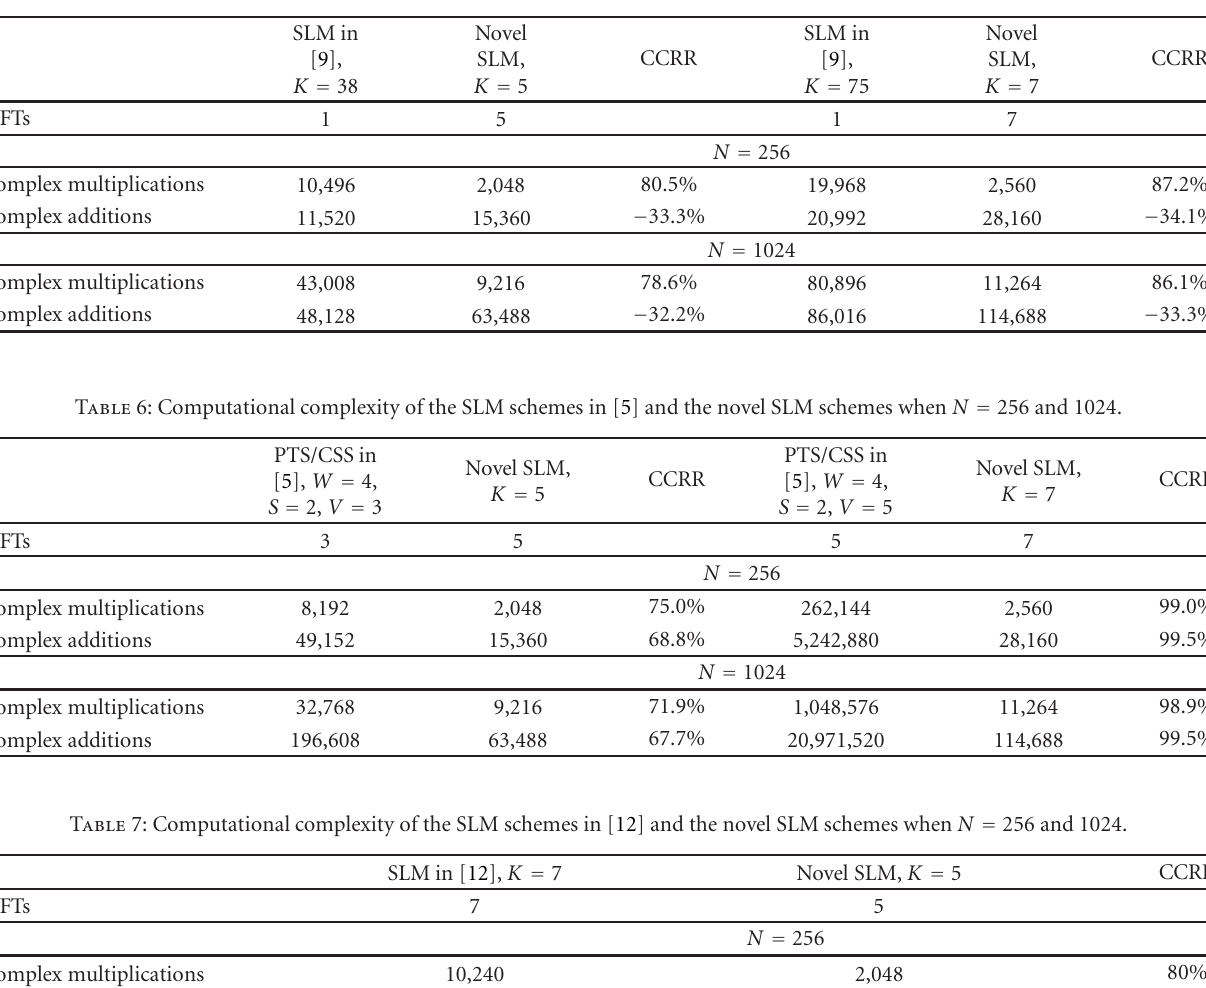
Table 5: Computational complexity of the SLM schemes in [9] and the novel SLM schemes when N = 256 and 1024.